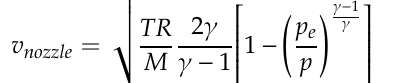
Figure 5. Time-averaged volumetric particle velocity as a function of the solid holdup and the nozzle inlet pressure.